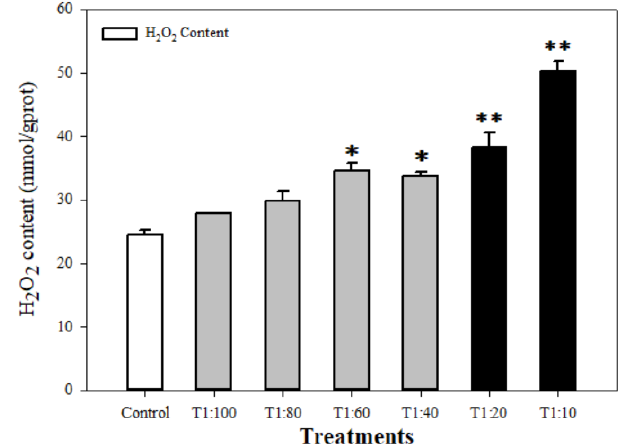
Figure 3. H 2 O 2 content of Ulva prolifera under the exposure of di ff erent amounts of cell-free filtrate of Bacillus cereus BE23. T 1:100 , and T 1:80 ~T 1:10 indicate the treatments of volume ratio of cell-free filtrate of Bacillus cereus BE23 relative to f / 2 medium. Values are means ± SD (n = 3). * indicates a significant di ff erence ( p < 0.05) and ** indicates a significant di ff erence ( p < 0.001) compared to